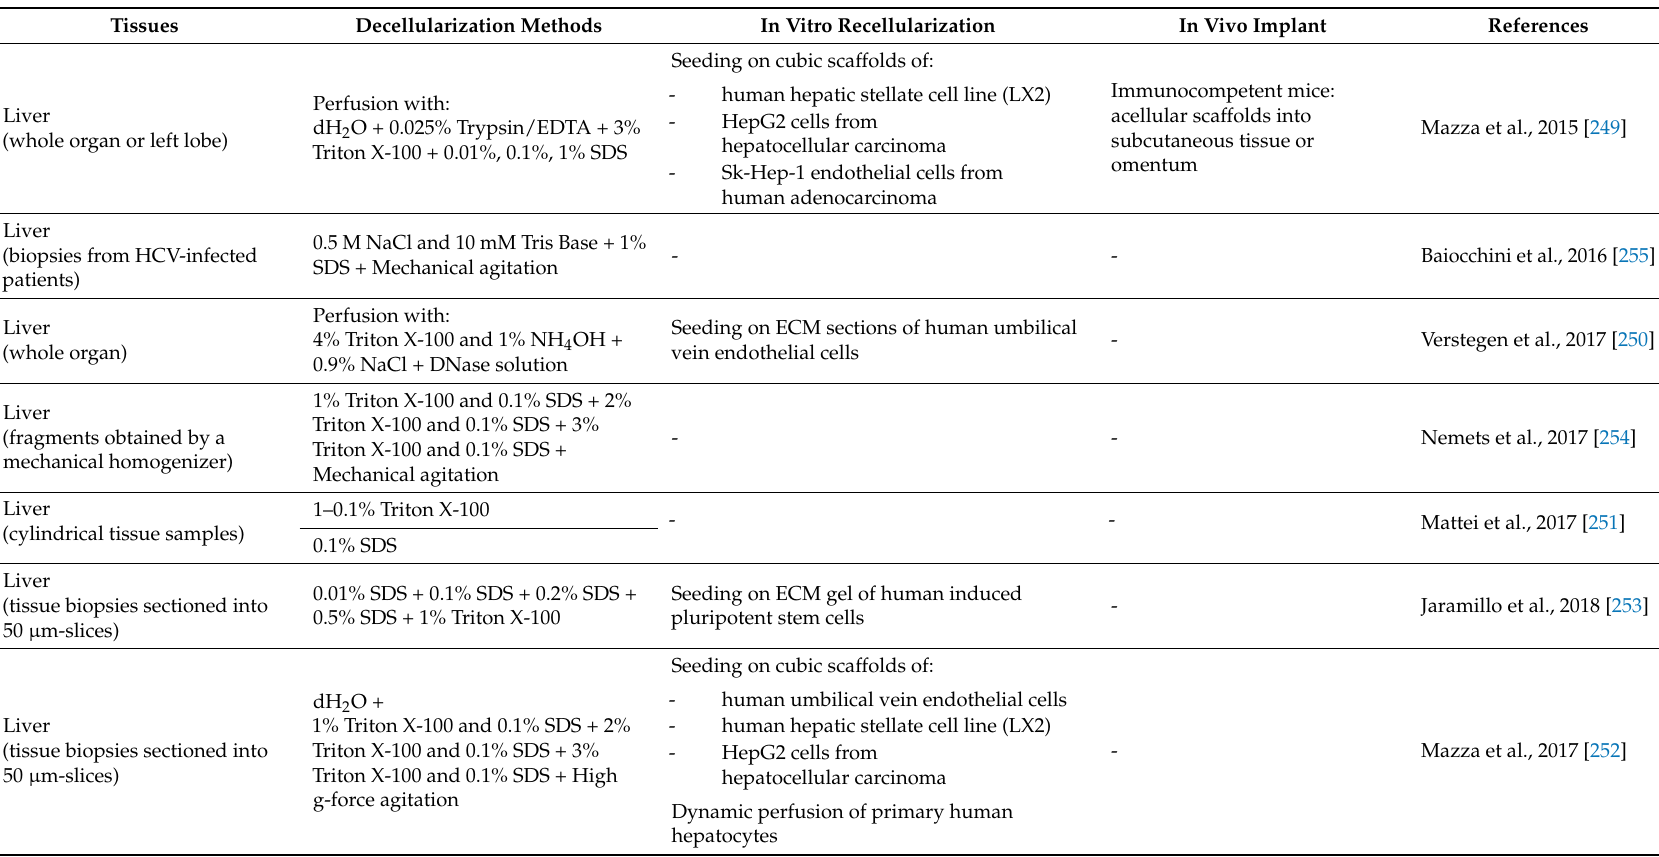
Table 7. Liver. Decellularization techniques, recellularization methods, and in vivo implant of human hepatic extracellular